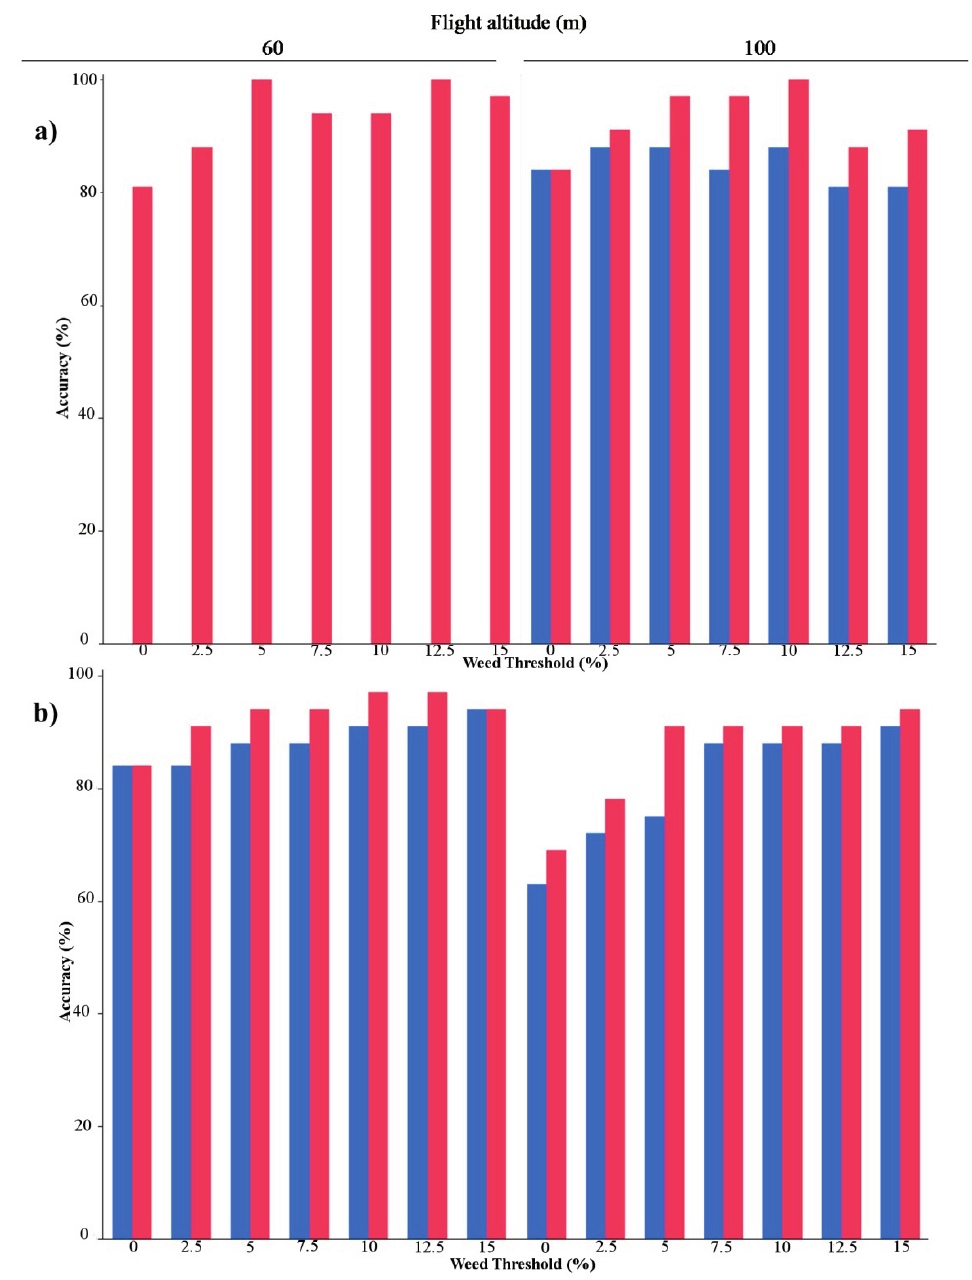
Figure 5. Accuracy (%) of match in the classification ( Treatment or No-Treatment ) of the 32 frames according to seven weed thresholds for the RS-image with the still visible and multispectral cameras (blue: RGB; red: TTC) at 60 m and 100 m altitude for ( a ) Field 1; ( b ) Field